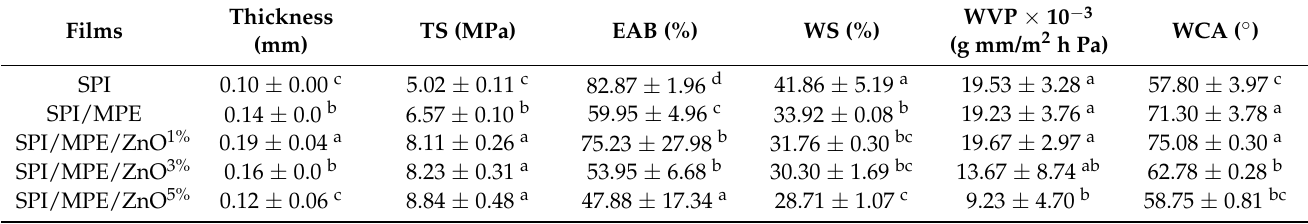
The values are averaged ± Standard deviation. Different letters in the same column show a significant difference ( p ≤